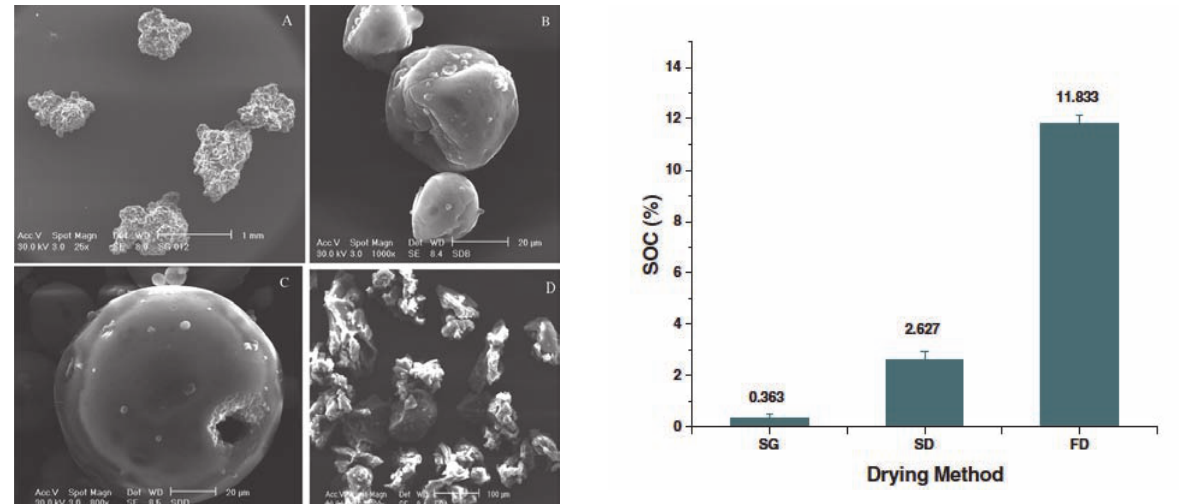
Fig. 6 Scanning electron micrographs of fish oil microcapsules produced by spray granulation (SG; a), spray drying (SD; b,c) or freeze drying (FD; d). The lowest surface oil content (SOC) was found for the spray-granulated product 93)